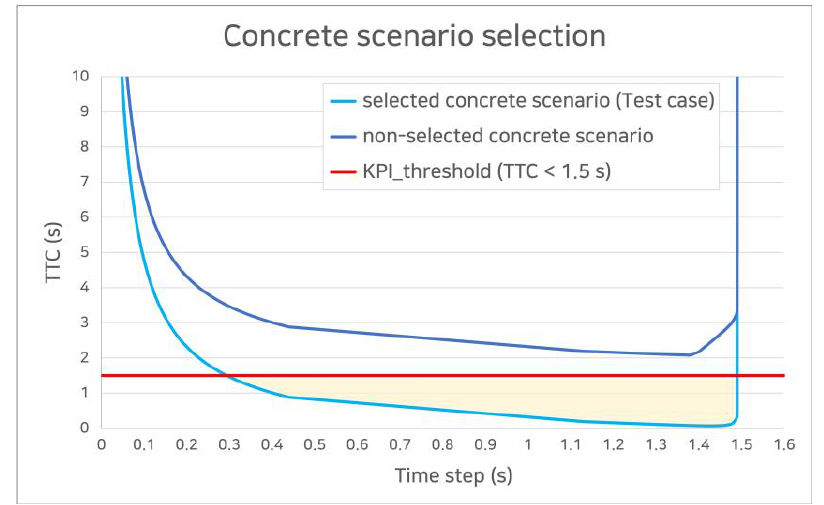
Figure 5. Examples of test case selection.